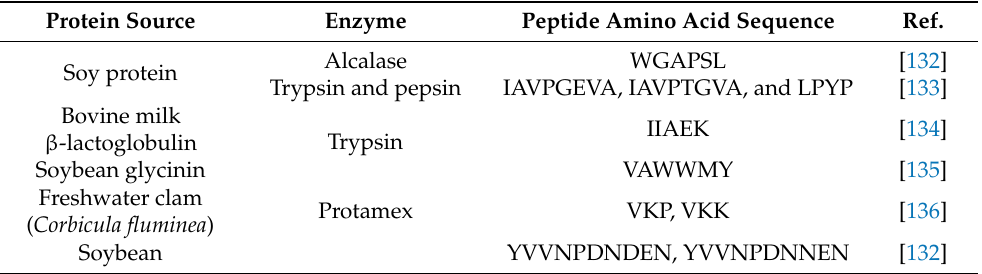
Table 3. Hypocholesterolemic activity of bioactive peptides obtained from different protein